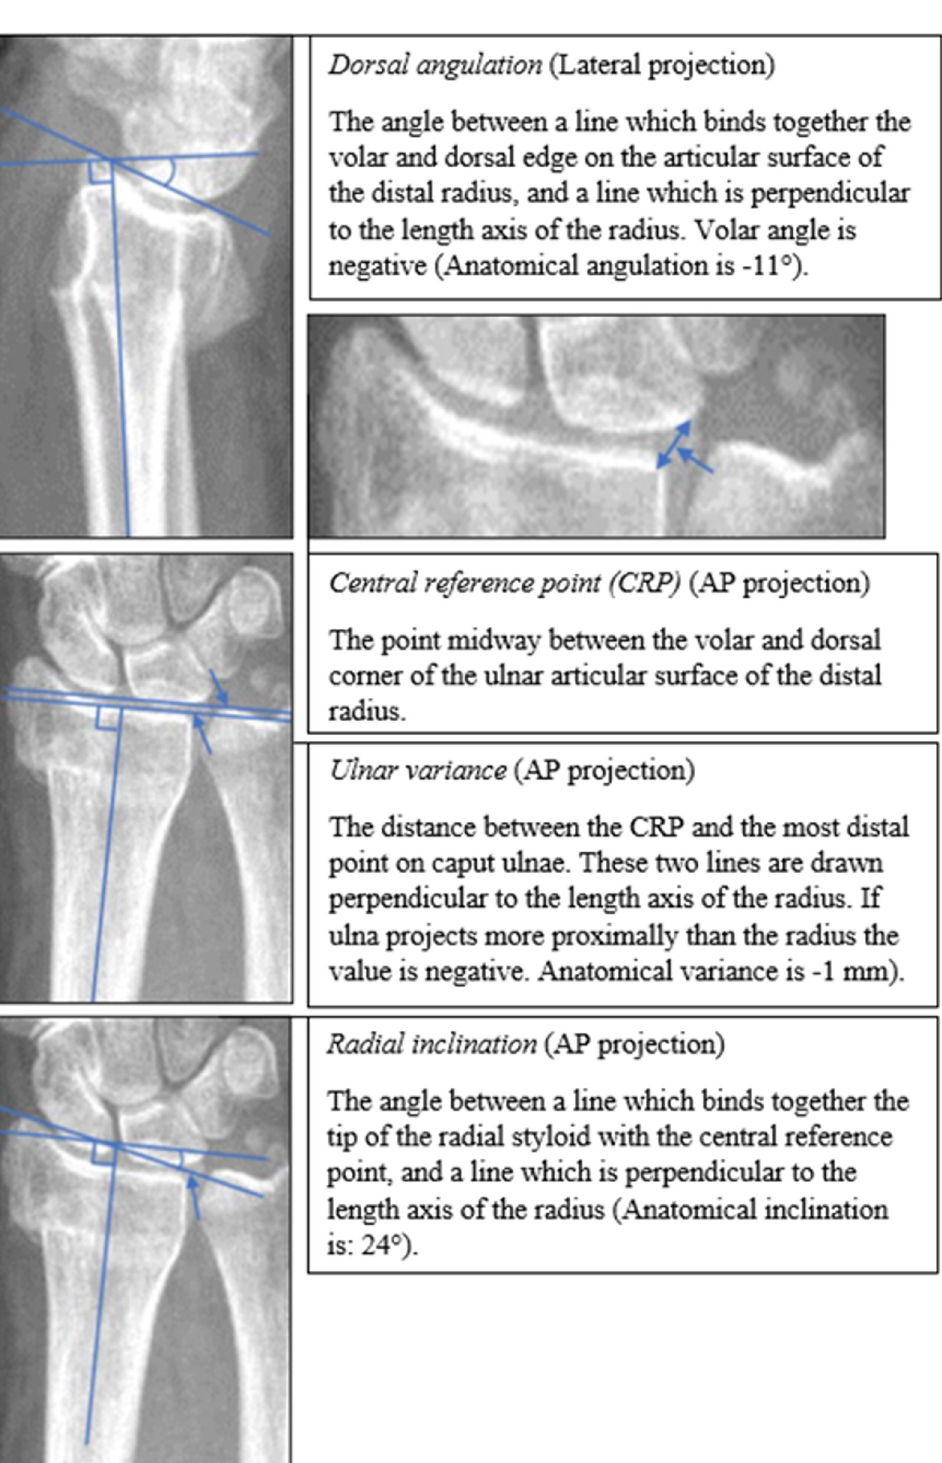
Fig 4. How radiological measurements were made in a retrospective cohort study of 1,635 DRFs in two hospitals in Sweden in 2014–2017.